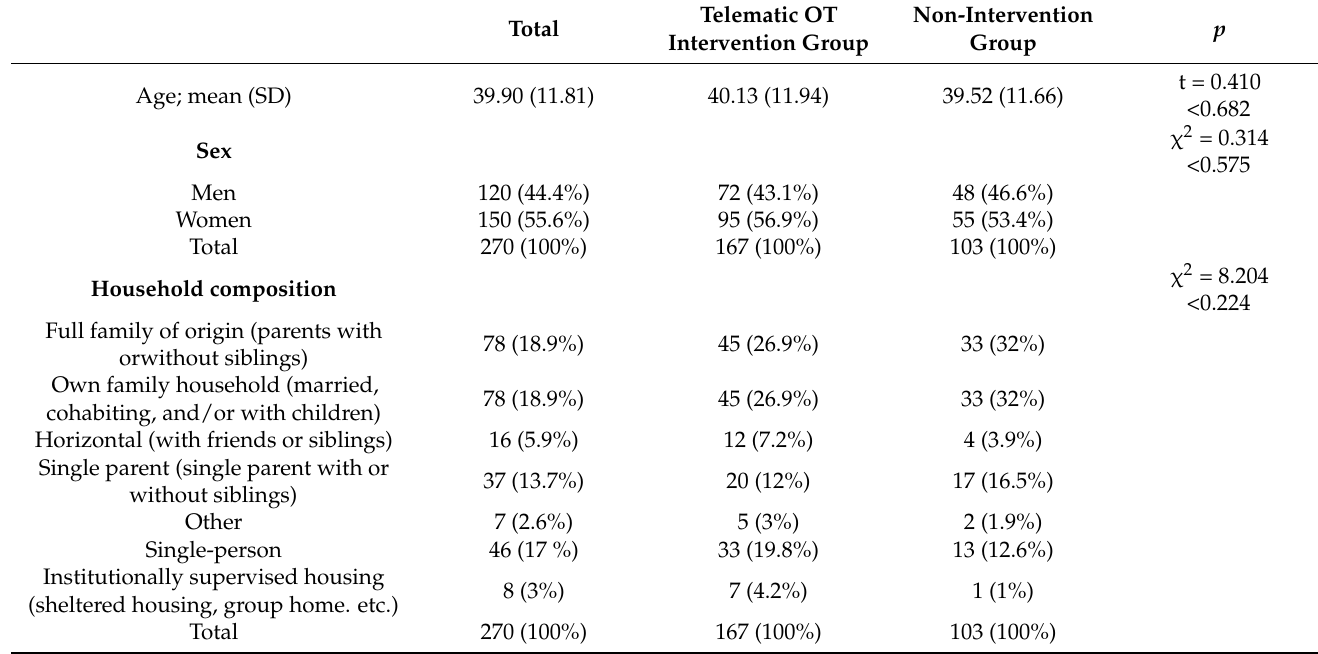
Table 1. Sociodemographic